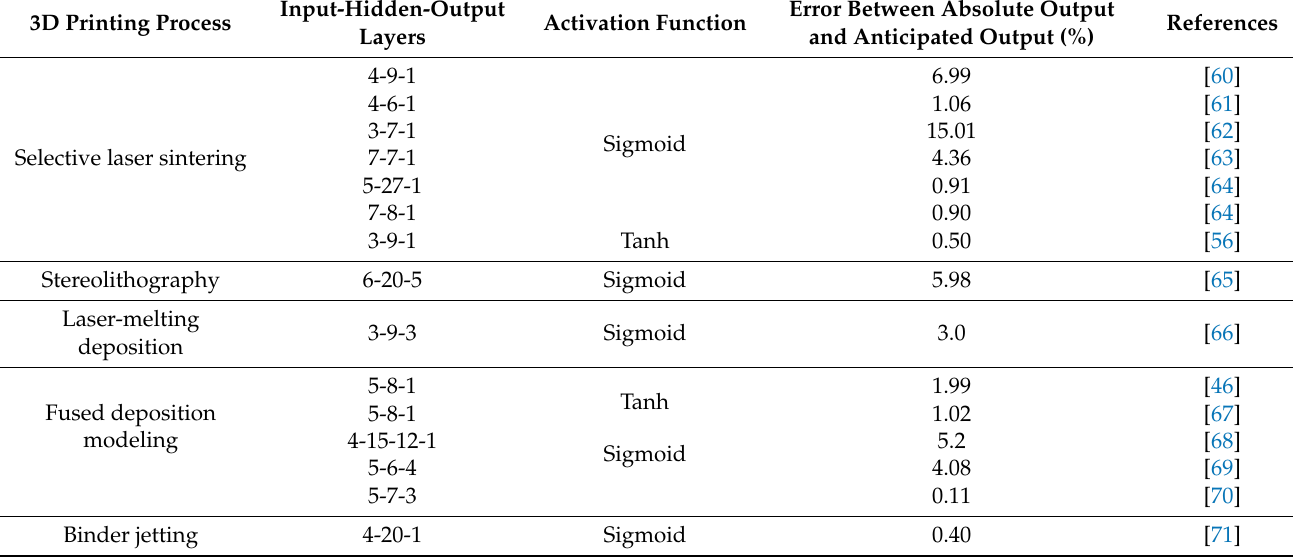
Table 4. ANN structure in various 3D printing processes.